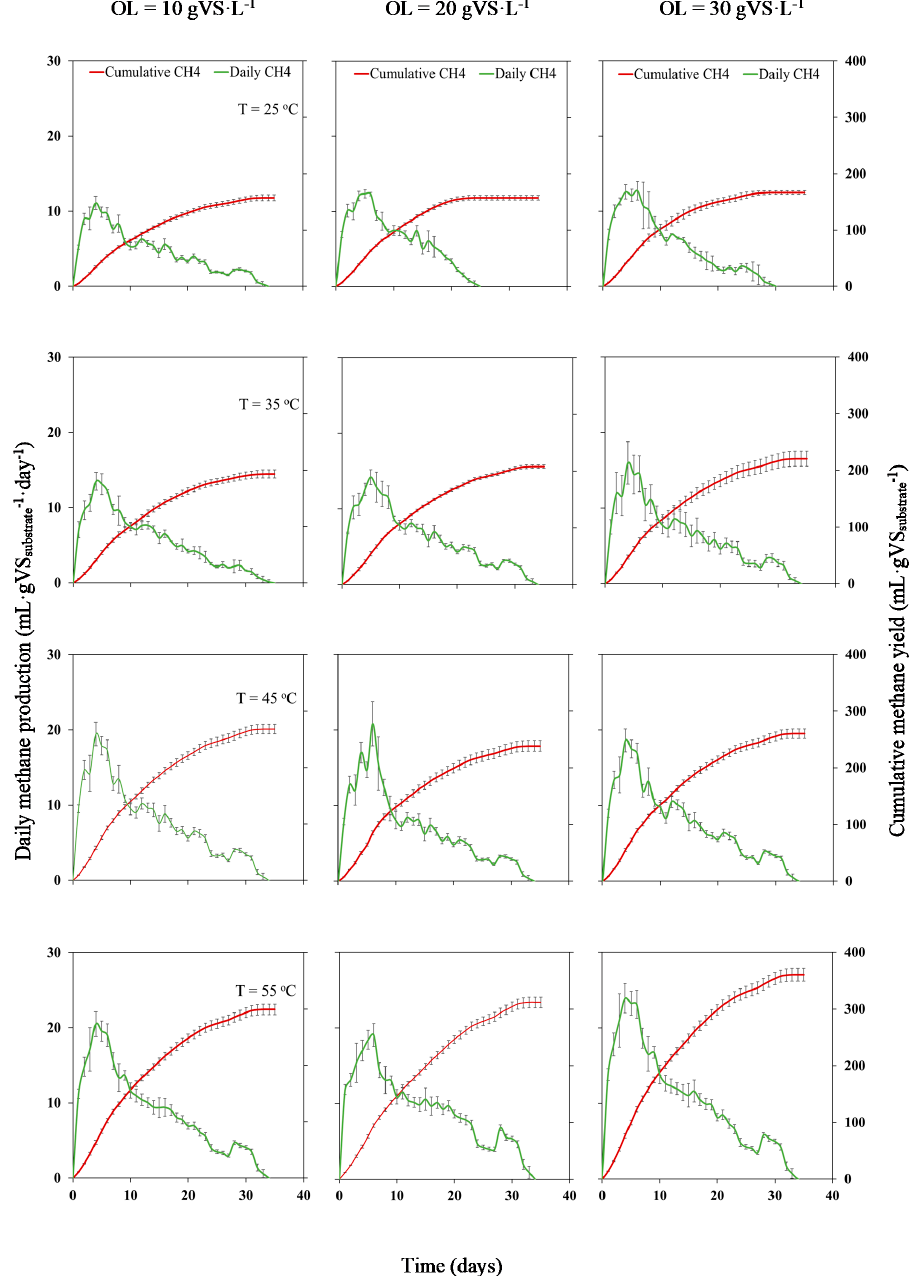
Figure 1. Daily and cumulative biogas production for all the reactors. − 1 Reactors with 30 g VS L (R10, R11, and R12) began rapidly to produce a high amount of biogas − 1 reaching 20.5, 19.1, and 23.9 mL g VS substrate on days 4, 6 and 4, respectively. The methane produced − 1 − 1 daily remained for the first 15 days in the range of 10–21 mL g VS substrate day and afterwards gradually declined to a lower level until the biogas production dropped to zero on day